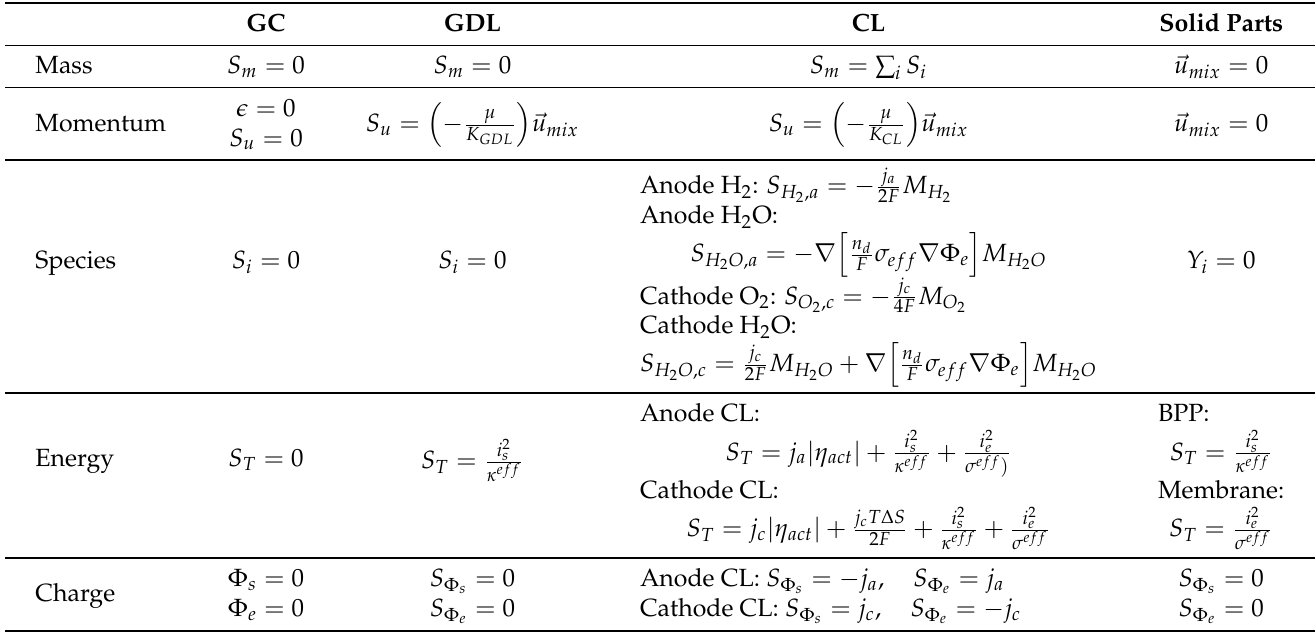
Table 2. Source terms for the mixture multi-phase (MMP) governing equations from in [5,24]. GC GDL CL Solid